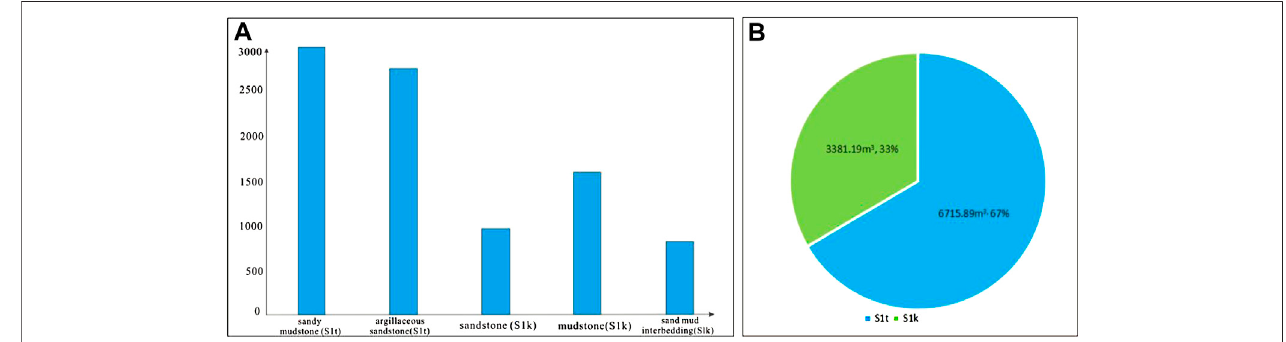
FIGURE7| ThehistogramoftheleakageofdifferentlayersandlithologiesintheSilurianinShunbeiarea. (A) Leakageofdifferentlithologies; (B) Leakageofdifferent strata.